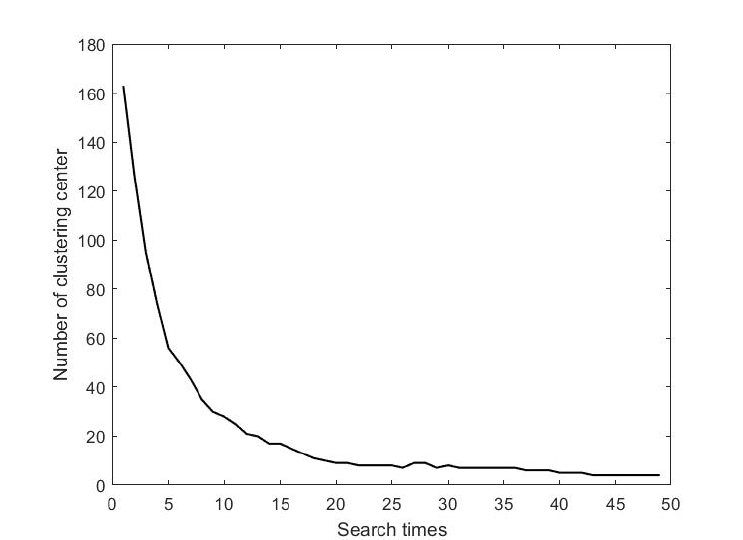
Figure 4. Pruning process of order selection under different neighborhood radius. The point p 1 in ( a ) represents the first cluster center, and p 2 , p 3 , p 4 in ( b – d ) represent the next cluster center, respectively. After p 4 is determined, the variance of the remaining points is larger than the threshold ρ . The following four pictures ( e – h ) are the pruning results after the enlargement of the neighborhood radius. Under these two different radius conditions, due to p 1 = p 5 , p 2 = p 6 , p 3 = p 7 , p 4 = p 8 , it can be considered that the result is stable, relatively. Therefore, the order selection result of these data under this algorithm is 4. The neighborhood radius in the four graphs of the above part is maxDistance , and in the other four 5 + maxDistance . The abandoning threshold is ρ = 0.2, stable parameter M = 2. graphs is maxDistance 5 50